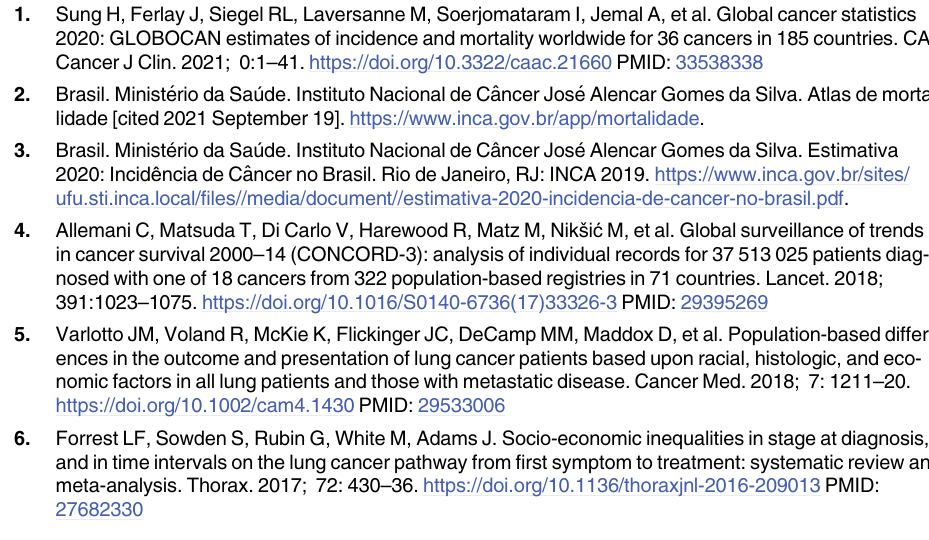
S2 Fig. Spatial association between age-adjusted mortality rates for lung cancer and the proportion of advanced-stage diagnosis of lung cancer, Brazil, 2011–2015. (TIF) S3 Fig. Analysis of residues for the spatial error model of lung cancer mortality Brazil, 2011–2015. (TIF) S1 Table. Models of spatial regression, according to the analysis criteria for selecting the final